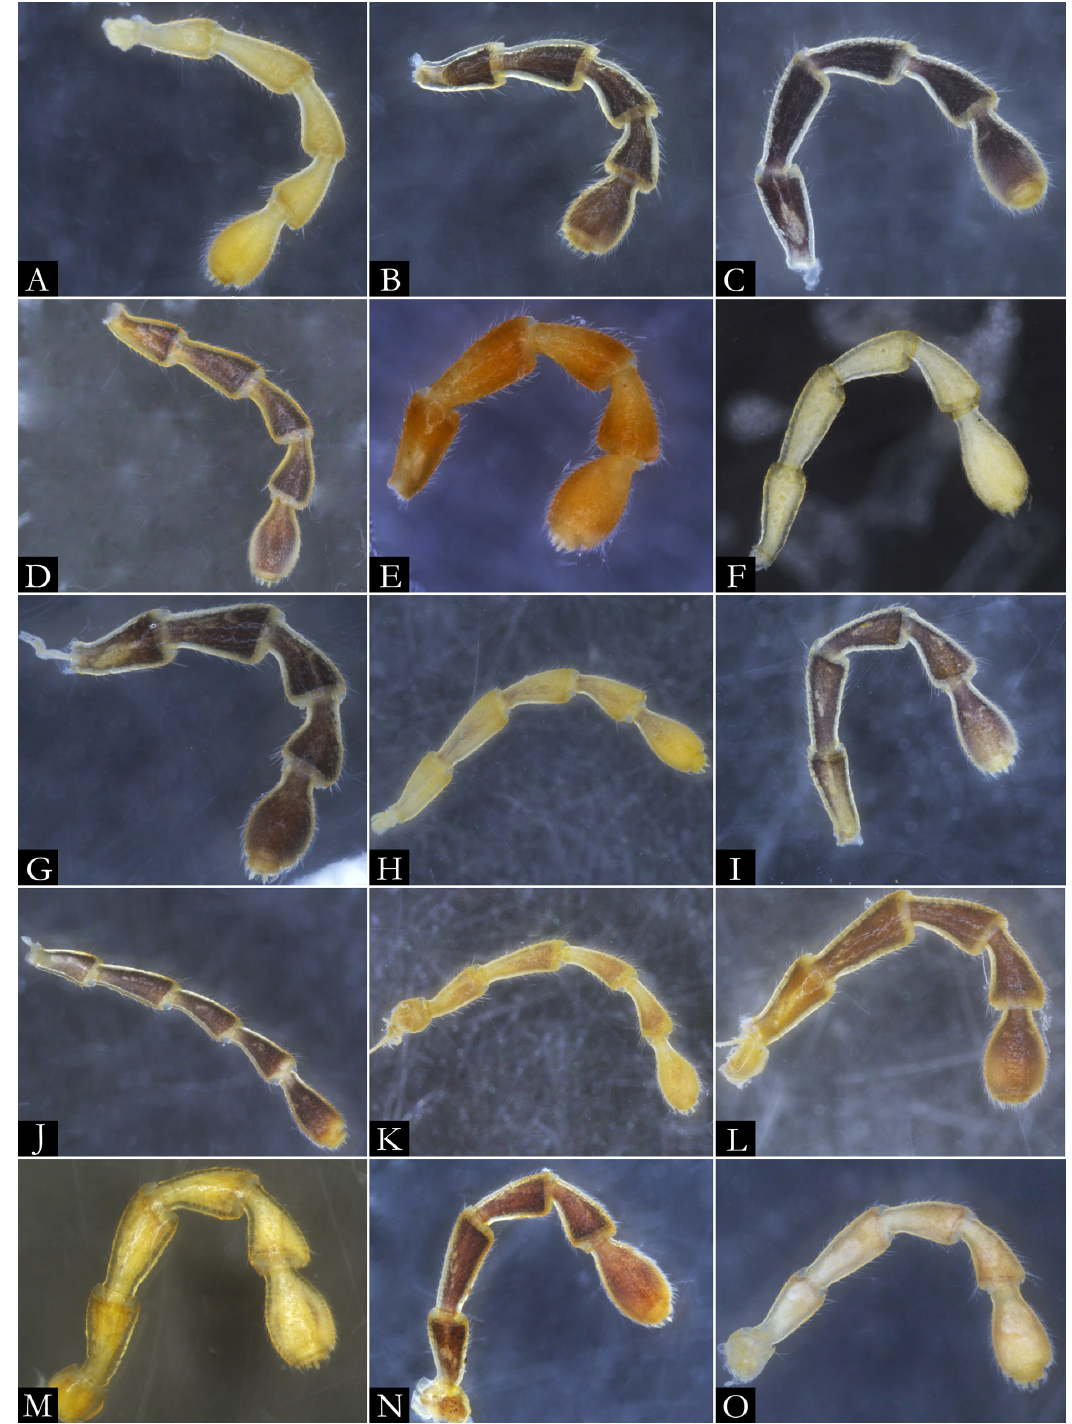
Fig. 164. Stereoscopic images of antennae of species of Pseudonannolene Silvestri, 1895 . A . P.